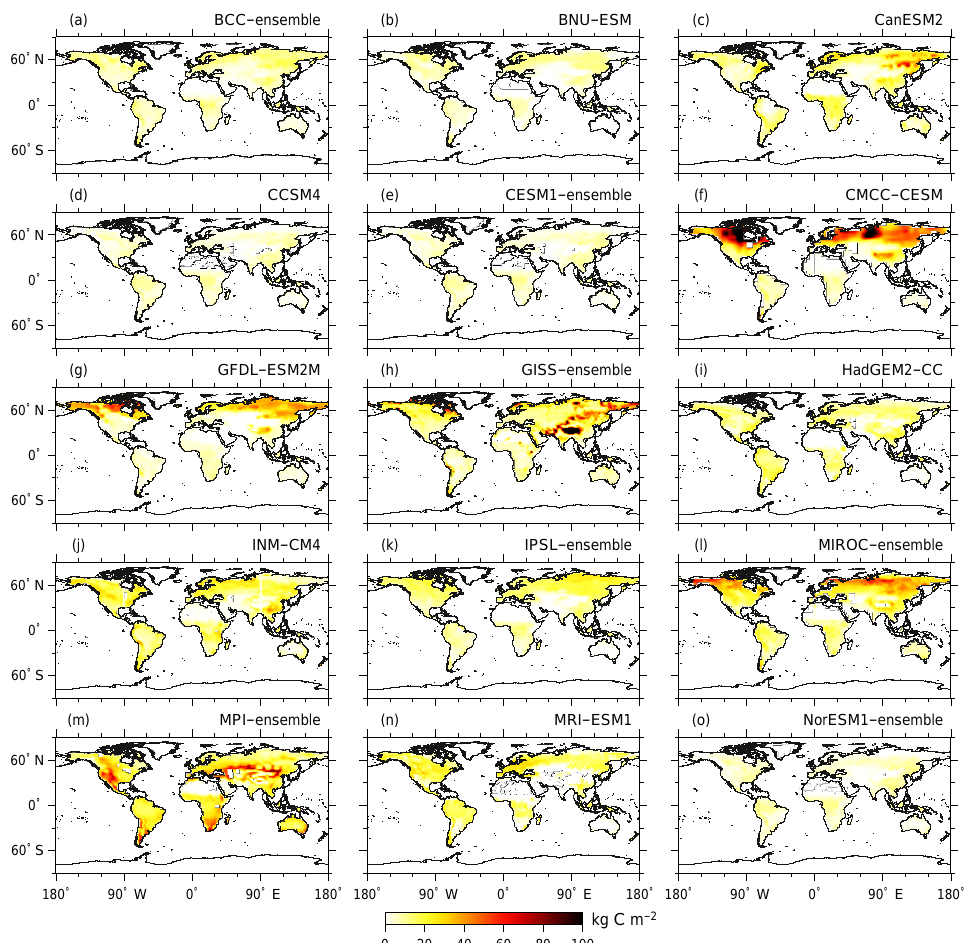
Figure 2. Soil carbon stocks (kgCm − 2 ) from Earth system models (CMIP5). The term “ensemble” indicates the result of an ensemble of family